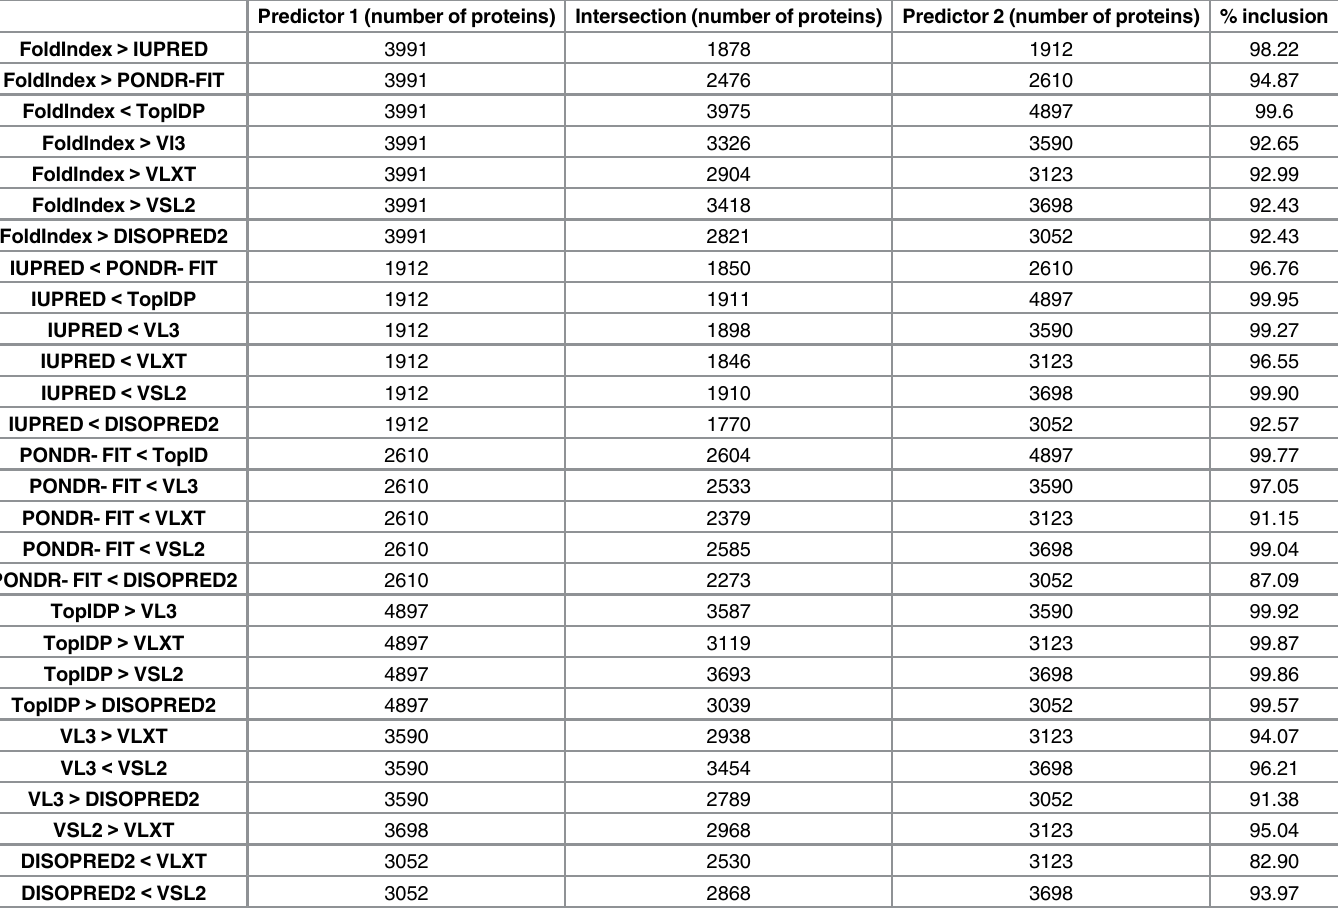
Table 1. Intrinsic disorder prediction overlap between different prediction